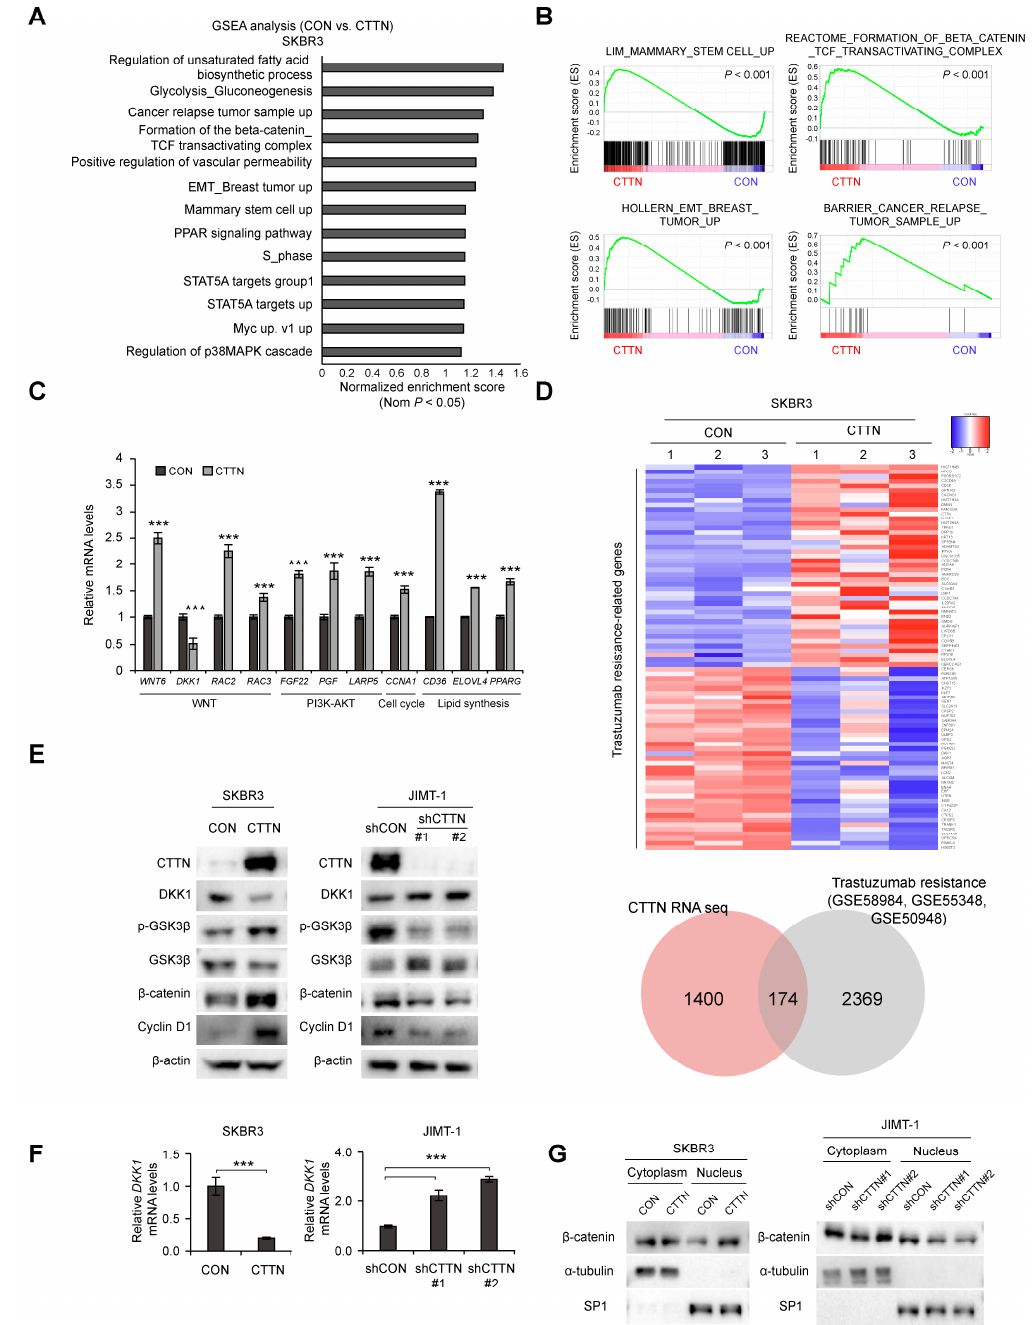
Figure 3. Overexpression of CTTN activates the Wnt signaling pathway by downregulating DKK-1 expression. ( A , B ) Analysis of the signaling pathways and gene signatures affected by CTTN overexpression in SKBR3 cells by gene set enrichment analysis (GSEA) of RNA-seq data. ( C ) Validation by qRT-PCR of the CTTN-target genes identified by RNA-seq. Data represent mean ± SD of three technical replicates. p -values were determined by two-tailed Student’s t -tests. *** p < 0.001 versus control. ( D ) Heatmap (top) showing the genes present in both the trastuzumab resistance-associated gene sets (GSE58984 [32], GSE55348 [33], GSE50948 [34]) and the set of genes differentially expressed ( ≥ 1.5-fold) in response to CTTN overexpression in SKBR3 cells (as obtained from the RNA seq data). The Venn diagram indicates numbers of overlapping genes. CON, control group; CTTN, CTTN overexpressing group. ( E ) Western blot showing DKK-1, β -catenin and cyclinD1 expression and phosphorylation levels of GSK3- β in SKBR3 and JIMT1 cells. CON, empty vector; CTTN, CTTN overexpression; shCON, shRNA control; shCTTN, CTTN knockdown. ( F ) qRT-PCR analysis of